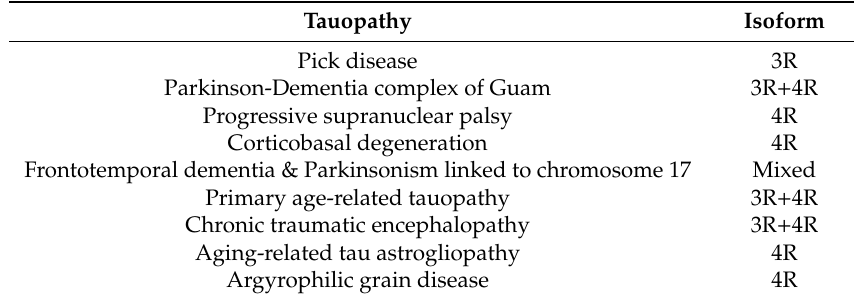
Table 3. 3R versus 4R tauopathies.